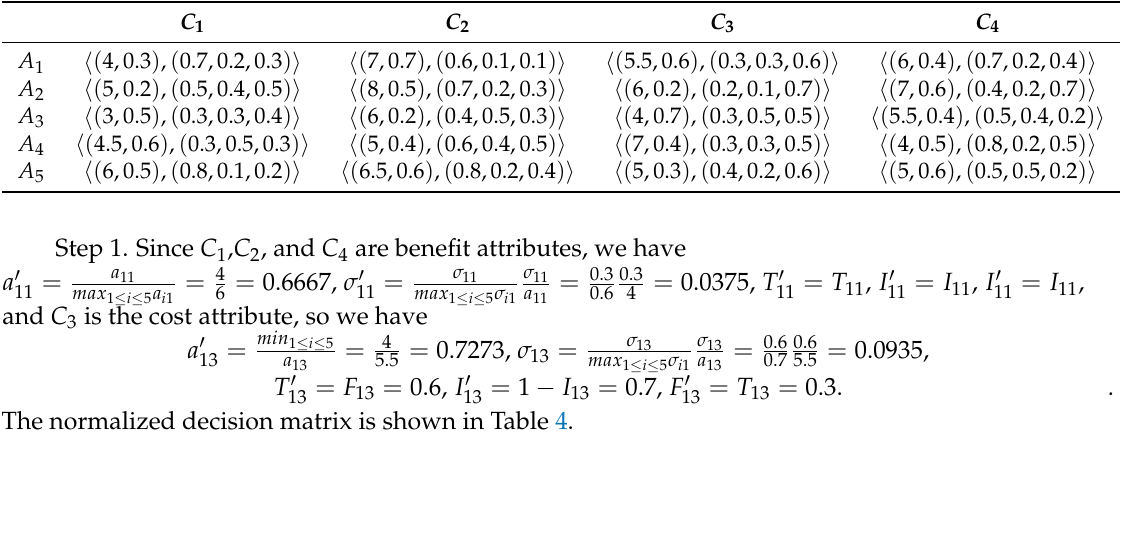
Table 3. The nonnegative normal neutrosophic decision matrix D